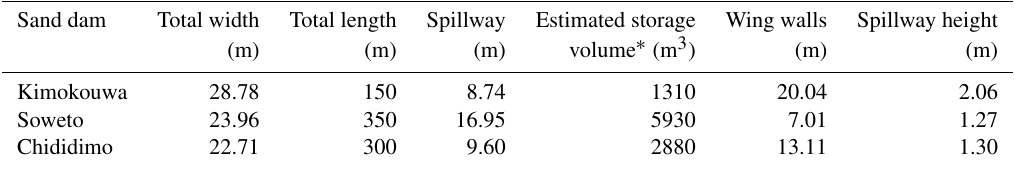
Table 1. Physical parameters of the three sand dams. Sand dam Total width Total length Spillway Estimated storage Wing walls Spillway